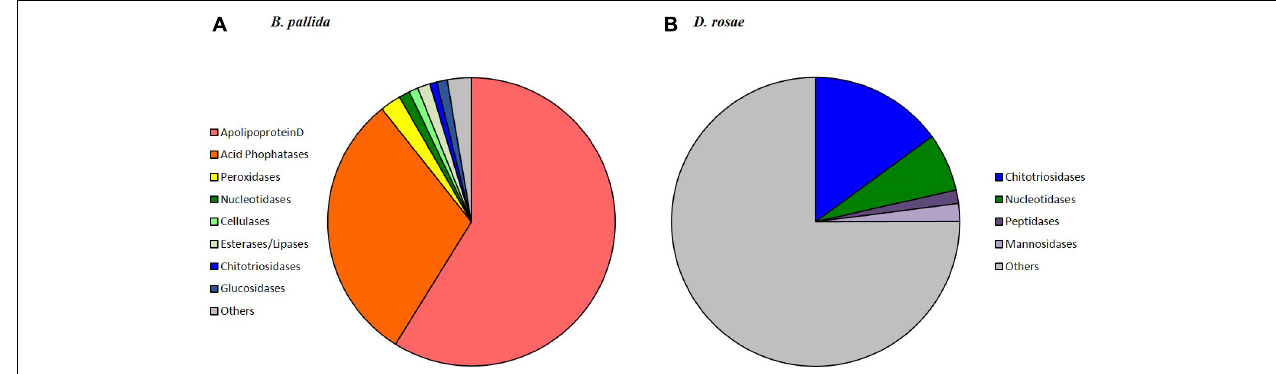
FIGURE 7 | Relative expression and annotation of B. pallida (A) and D. rosae (B) contigs differentially expressed in venom glands and potentially coding secreted proteins. Contigs considered here were only those returning a significant blastx hit ( E -value < 10 − 4 ) and having a predicted signal peptide or homologous to a protein possessing a signal peptide (contigs indicated by Y in Tables 2 , 3 from SignalP4.0 prediction). For each category, the sum of the reads (RPKM) in venom gland was calculated. For detailed description of contigs see Tables 2 , 3 . TABLE 4 | Comparison between B. pallida and D. rosae sequence s with known venom components from parasitoids a . Families Cynipidae Figitidae Pteromalidae Ichneumonidae Braconidae Bp Dr Lb Lh Nv Pp Hd Ph Md